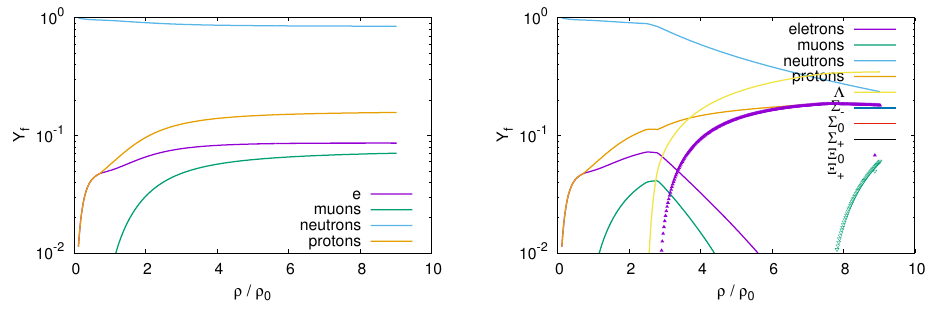
Figure 10. Particle fractions obtained with IUFSU for an EOS with ( left ) nucleons only and ( right ) lightest eight